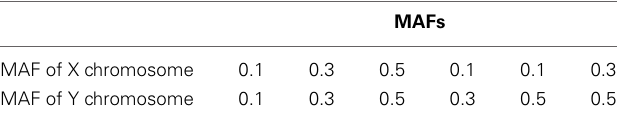
Table 1 | MAFs of QTLs for simulation study when no population stratification is present.